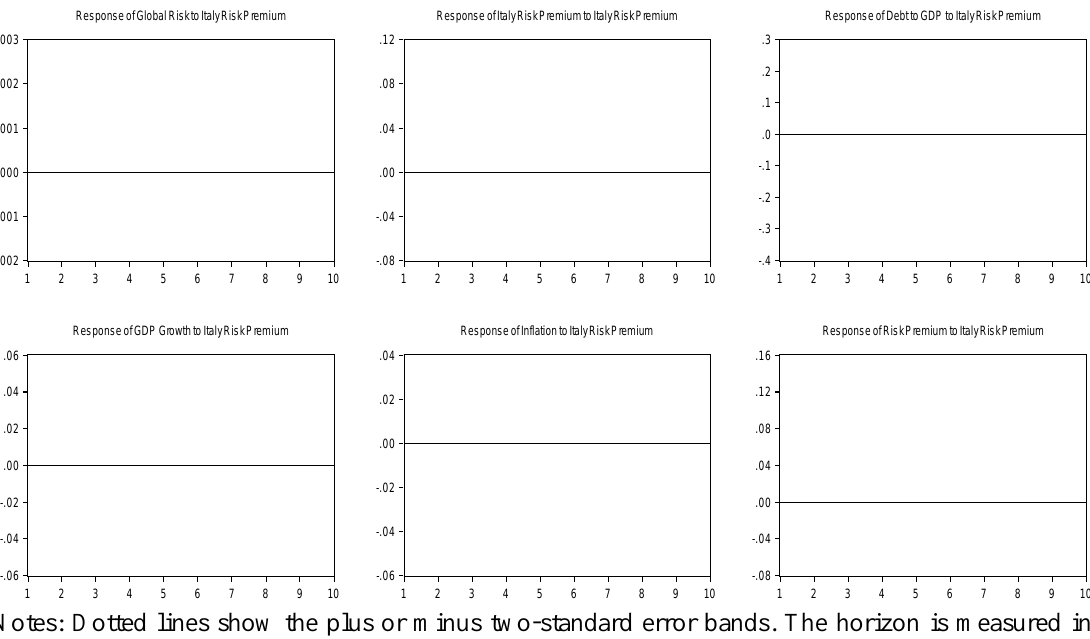
Figure 6. Pre-crisis response of EMU countries to a shock to Italy’s risk premium: 2001–2007.